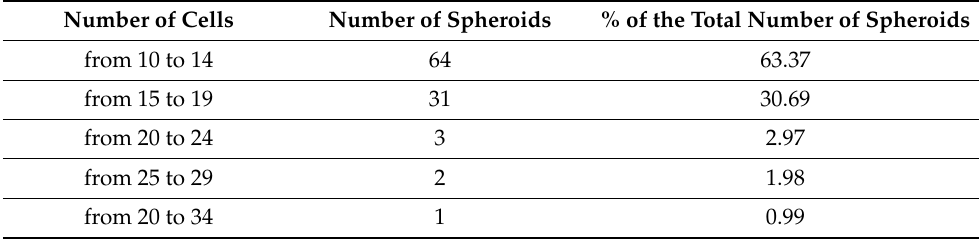
Table 1. Spheroids’ differentiation depending on the number of Table 1 . Spheroids’ differentiation depending on the number of cells.